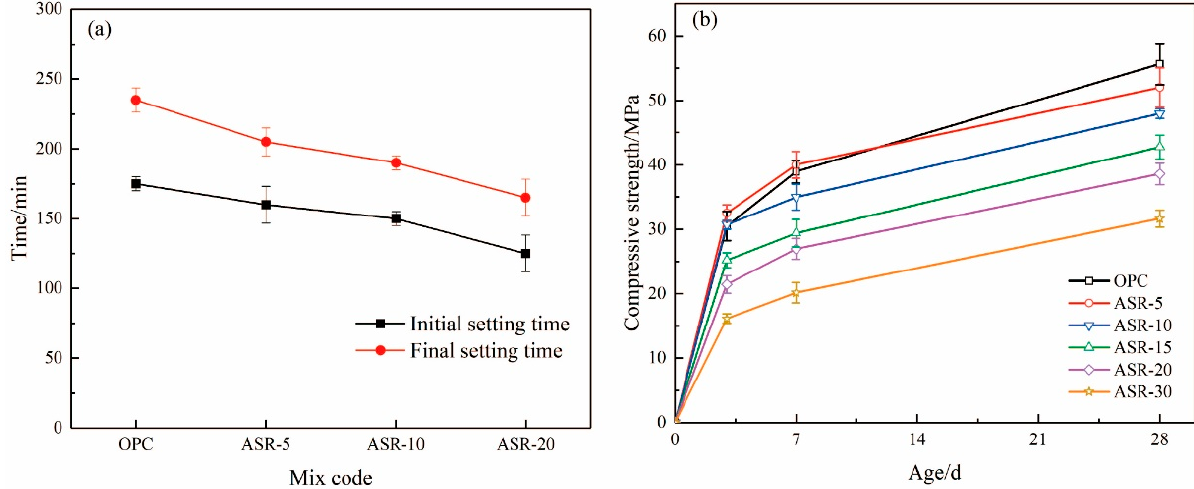
Figure 8. The setting time ( a ) of ASR-cement composite cementitious material and ( b ) mortar compressive strength. The compressive strengths of the mortars test at 3 d, 7 d, and 28 d are shown in Figure 8b. At the 3 days age, the mortar sample with 5% ASR content had the highest compressive strength of 32.5 MPa, which is 6.6% higher than the OPC control group. The